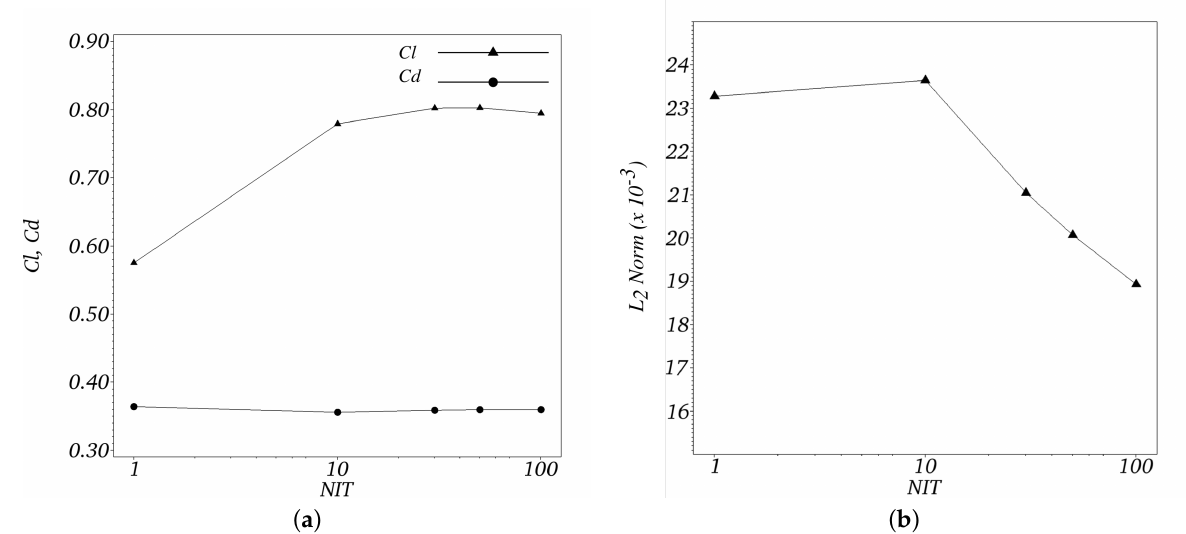
Figure 10. ( a ) Variation of mean C l and C d as a function of the number of NIT interactions. ( b ) Tem- poral mean of the L 2 norm of horizontal Lagrangian velocity as a function of NIT